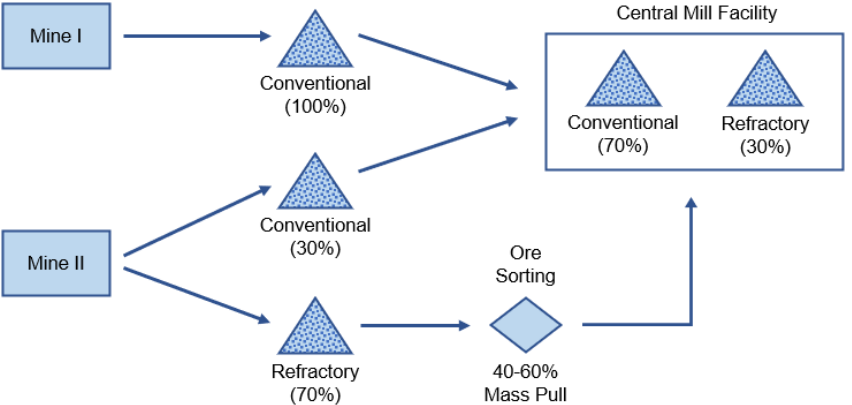
Figure 4. Diagram illustrating the problem concept for the current set of sample calculations. Mine I refers to the producing mine with which the mill is currently integrated; Mine II refers to the satellite deposit under consideration. Expected ore compositions are only approximate and do not account for geological uncertainty.